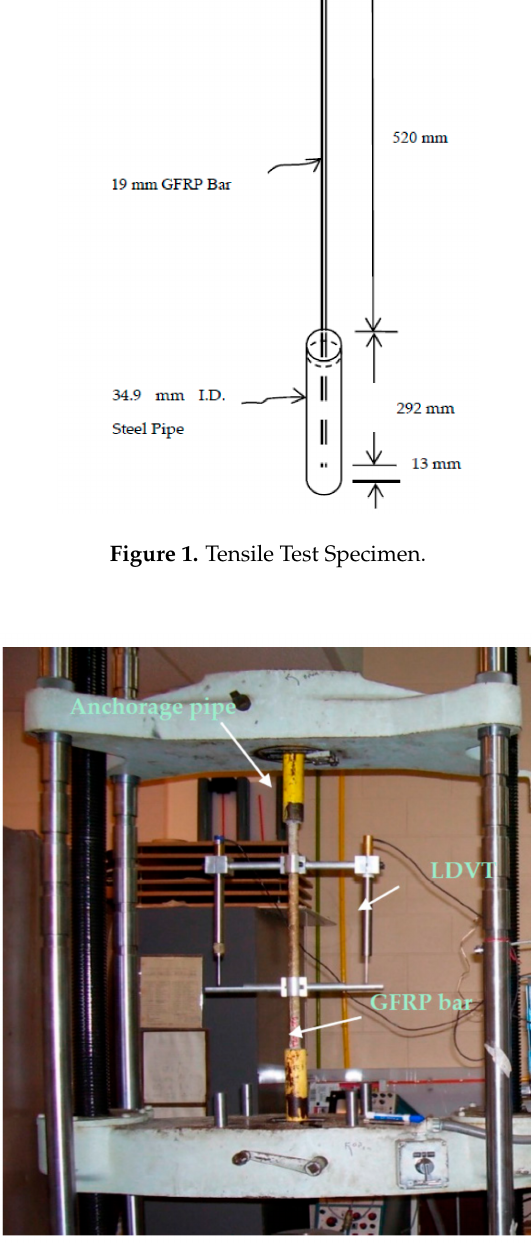
Figure 2. Tensile Test set